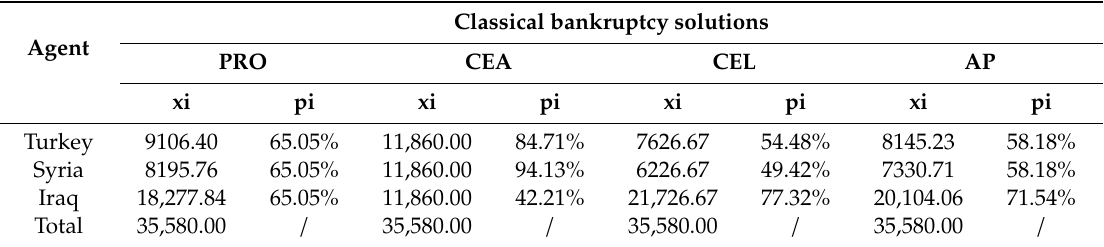
Table 5. Solutions derived from four classical bankruptcy rules of PRO, CEA, CEL, and AP. Agent